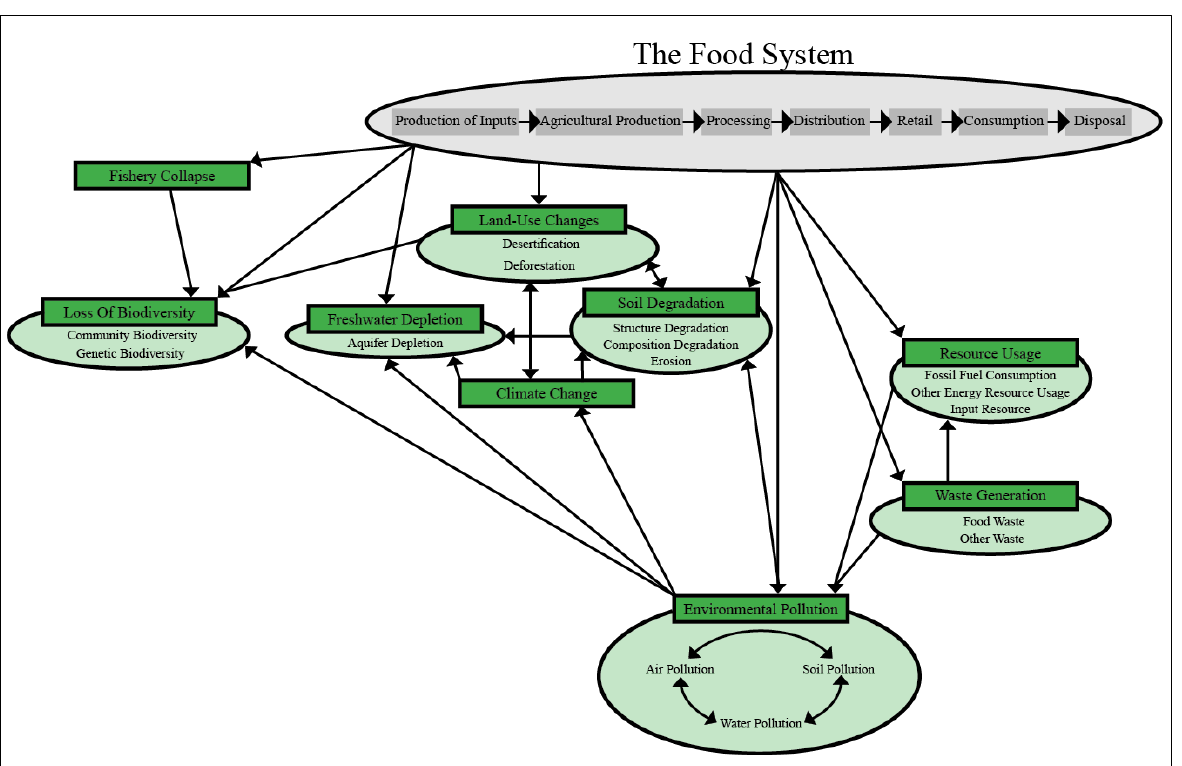
Figure B1. Environmental Outcomes Map of the U.S. Food System, Outcomes Derived from the Literature